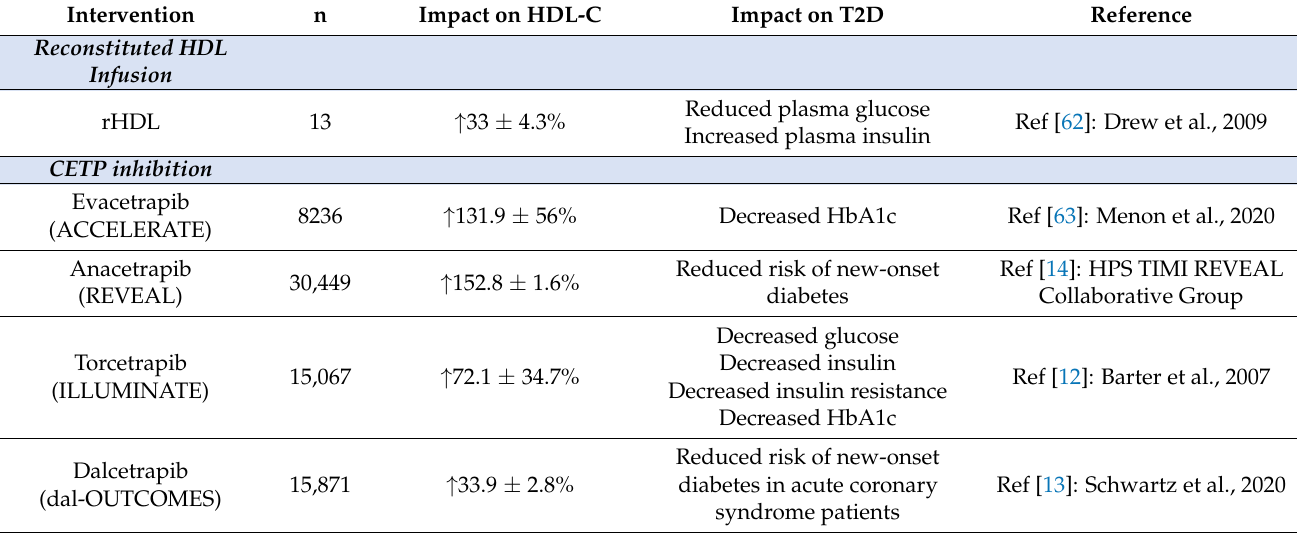
Table 1. Summary of randomised clinical trials demonstrating the antidiabetic functions of HDLs in humans. Intervention n Impact on HDL-C Impact on T2D